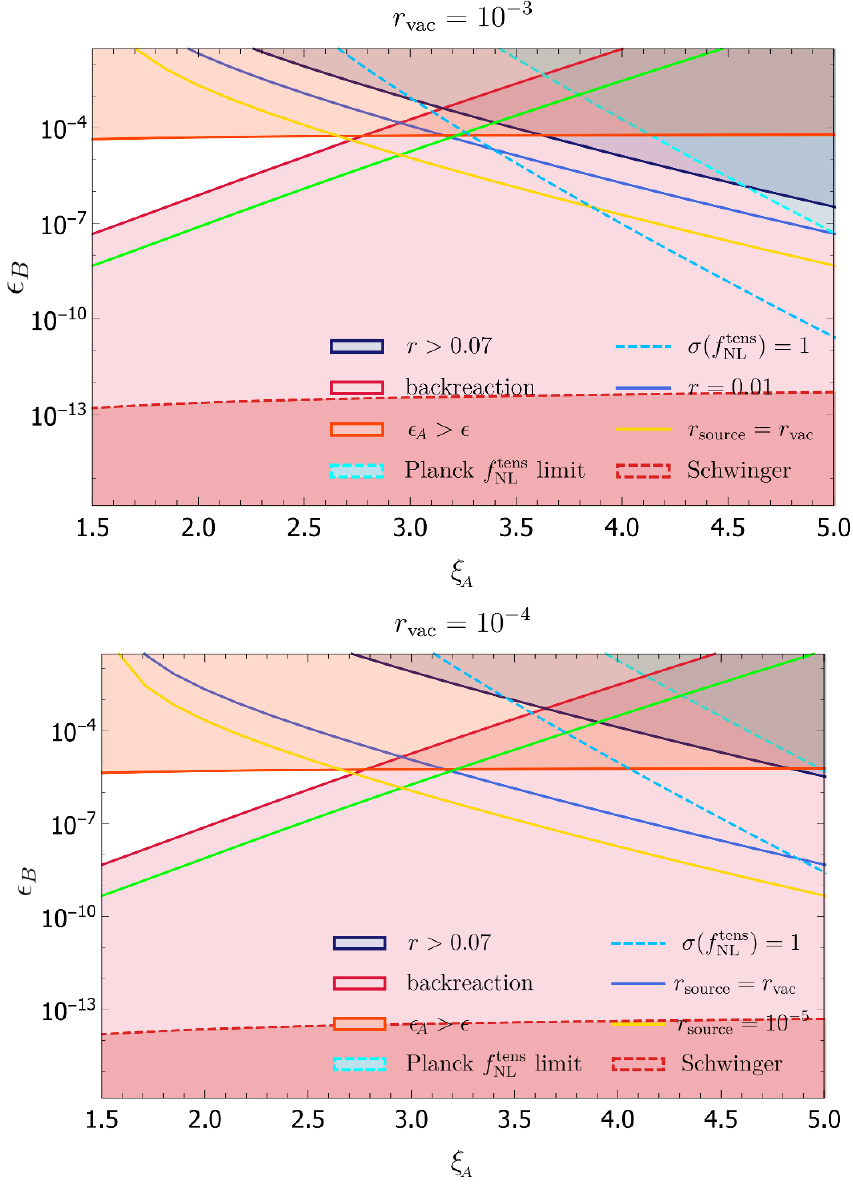
Figure 13 . Same as (cid:12)gure 12 but for r vac = 10 (cid:0) 3 (top) and 10 (cid:0) 4 (bottom). In the top panel the blue and yellow lines show r = 10 (cid:0) 2 and r source = r vac , respectively, whereas in the bottom panel they show r source = r vac and r source = 10 (cid:0) 5 , respectively.